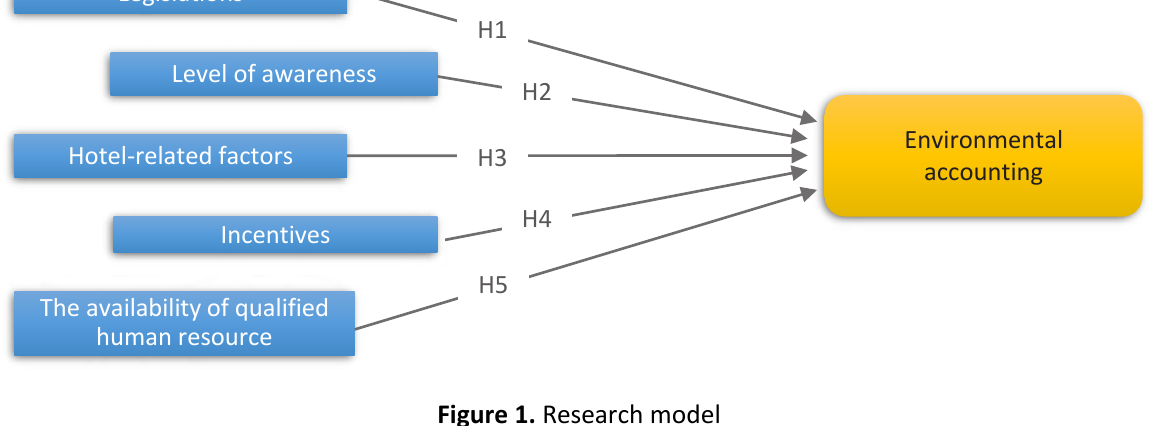
Figure 1. Research